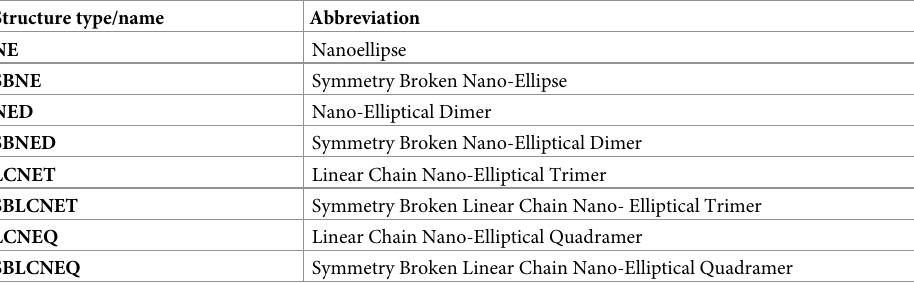
Table 3. Structure types and respective